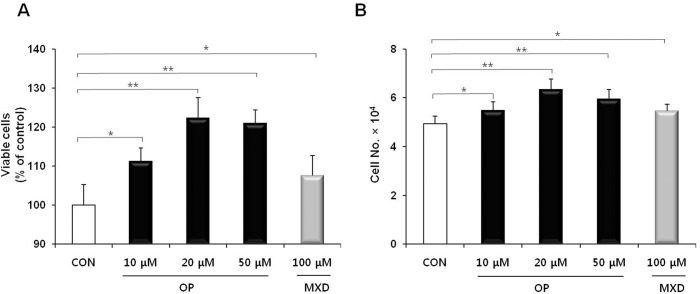
Effect of oleuropein on DPC proliferation.DPCs (3 × 104 cells/well) were treated with various concentrations of oleuropein (OP) or minoxidil (MXD), as indicated. (A) Viable cells were determined by MTT assay. (B) Cells were counted by trypan blue exclusion. The values are the mean ± SD of triplicate determinations from three independent wells. * = P < 0.05 and ** = P < 0.01 vs. control.